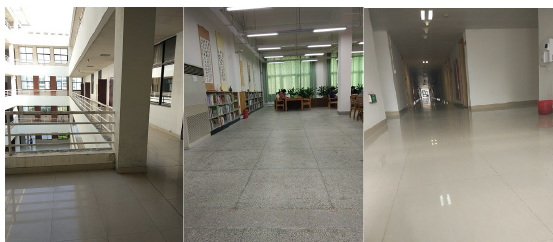
Figure 4. Different scenarios.